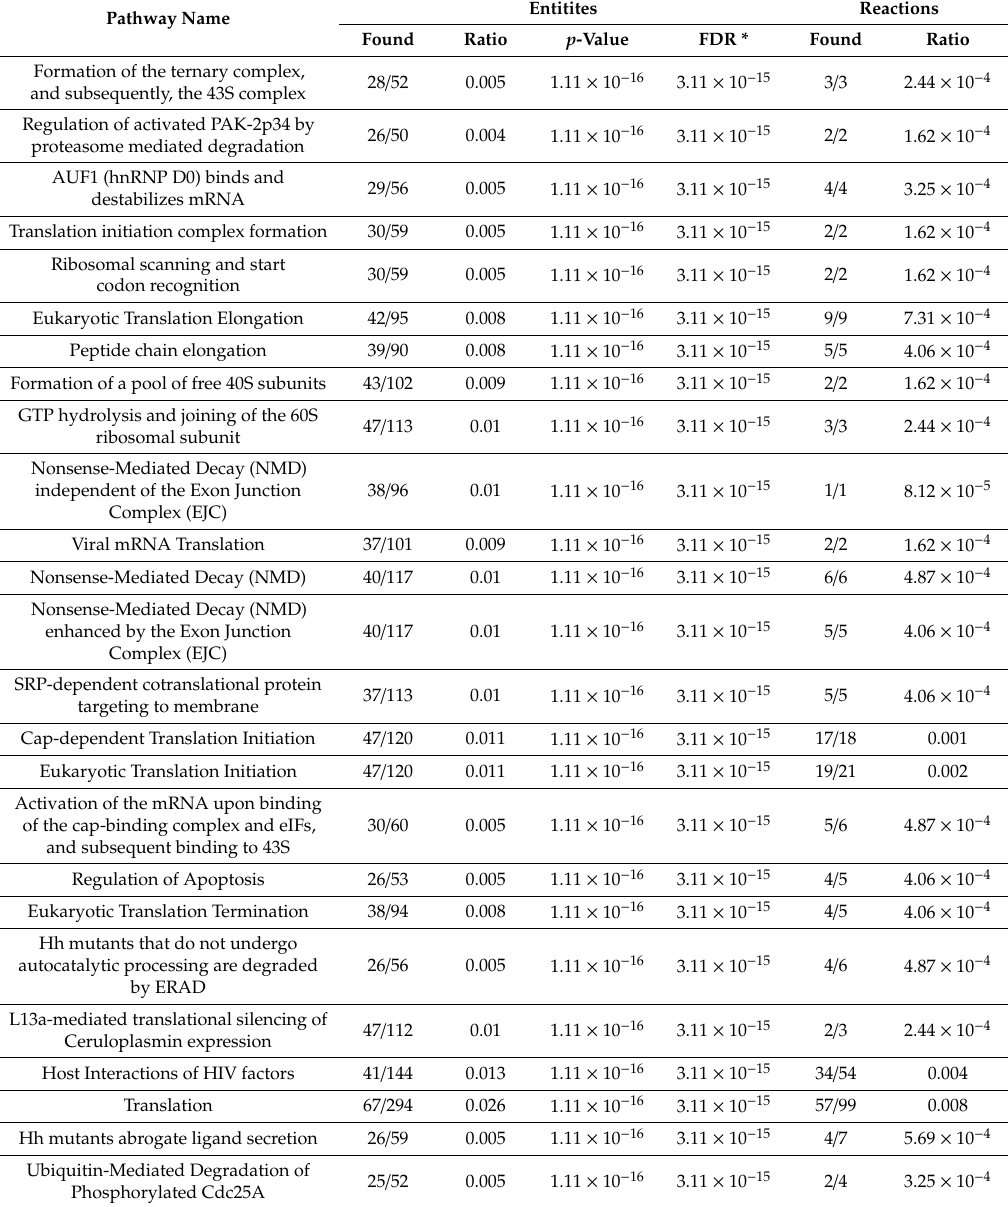
Table 1. List of the top 25 pathways associated with proteins present in unwounded hCE-TJ-derived EVs. Results were obtained from https: // reactome.org based on input of the accession number of proteins detected by